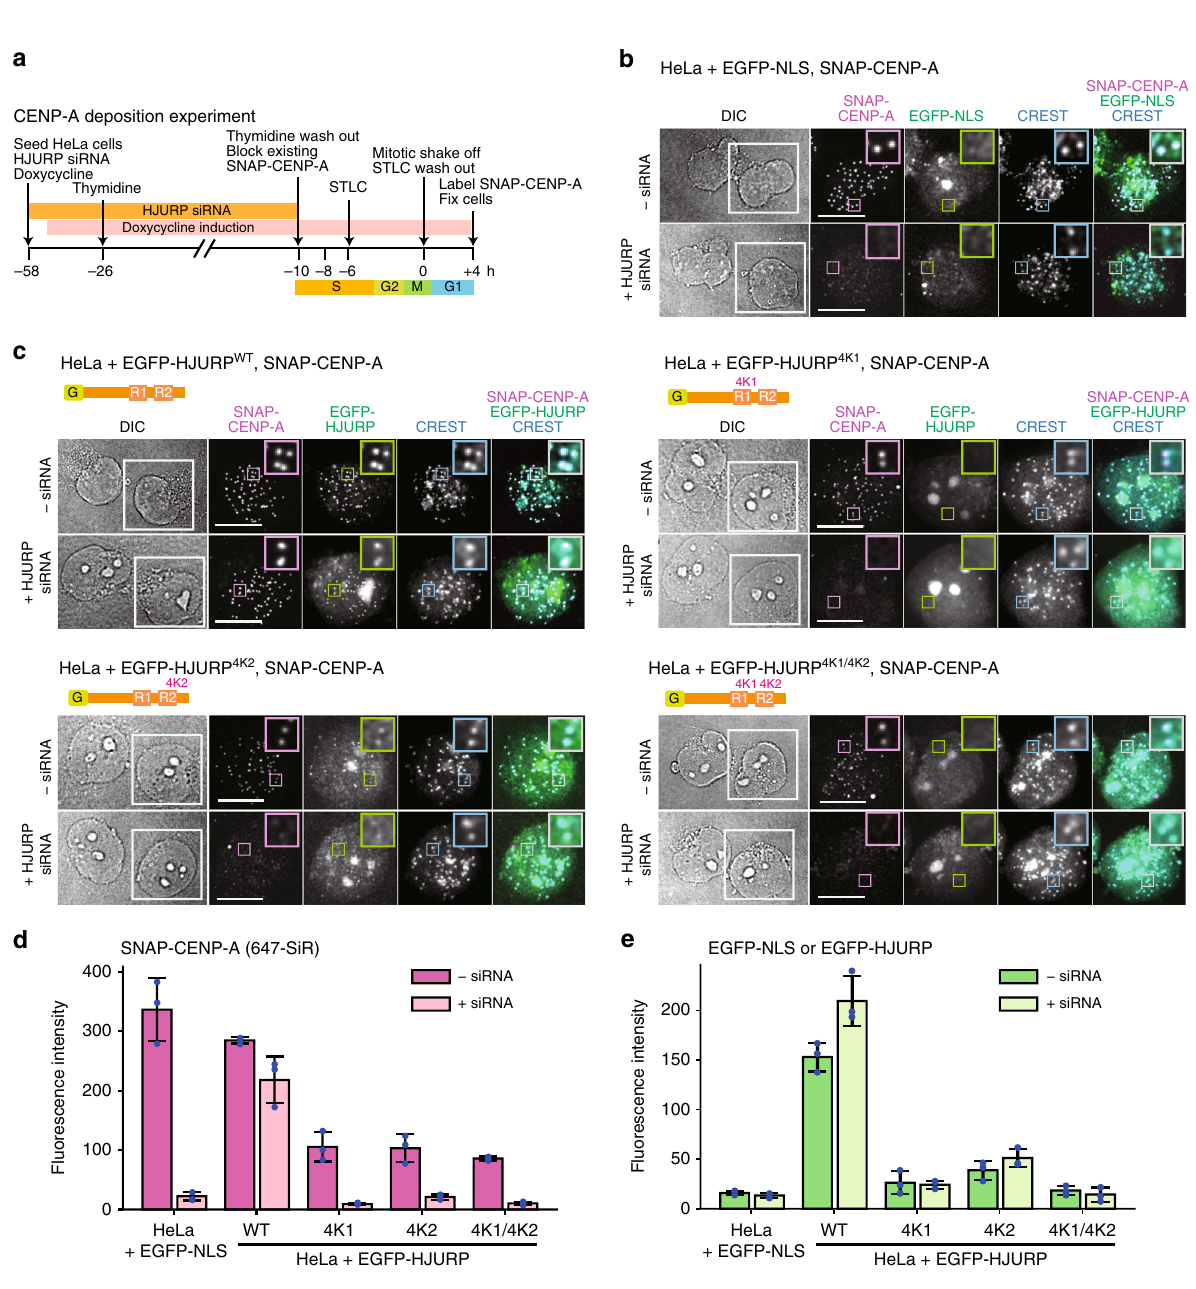
Fig. 2 Four-lysine mutations in HJURP R1 or R2 disturb HJURP localization and CENP-A deposition. a Schematic of the CENP-A deposition experiment for testing functionality of HJURP variants. SNAP-Cell 647-SiR was used to label newly produced SNAP-CENP-A at the time point + 4 h. b , c Representative images showing SNAP-CENP-A fl uorescence and EGFP-NLS or EGFP-HJURP variants in fi xed HeLa cells treated as described in panel a . Centromeres were visualized with CREST sera. Control cells were treated with transfection reagent (Lipofectamine RNAiMAX) in the absence of HJURP siRNA. DIC, differential interference contrast. One side of the white square in the DIC panel represents 20 µ m. White scale bars indicate 10 µ m. All cell biological experiments in this paper were repeated at least three times. d Quanti fi cation of the centromere fl uorescence intensity of SNAP-CENP-A. Centromere spots were detected using the images of CREST channel and were applied to the images of other data channels. In each experiment, a mean value of centromere fl uorescence intensity was obtained from at least 340 centromere spots from at least 20 early G1 cells. The highest 10% and the lowest 10% intensity values were considered outliers and excluded. The bar graph represents mean values from the three replicate experiments (blue dots indicate the mean values from each experiment). Error bars indicate standard deviations. The ways of quanti fi cation and representation described here apply to other fi gures displaying experiments in HeLa cells. e Quanti fi cation of the centromere fl uorescence intensity of EGFP signal. Source data are provided as a